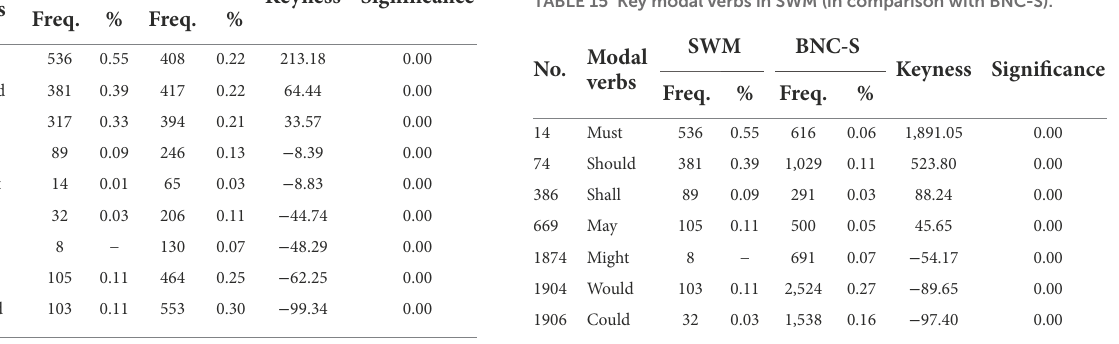
TABLE 15 Key modal verbs in SWM (in comparison with